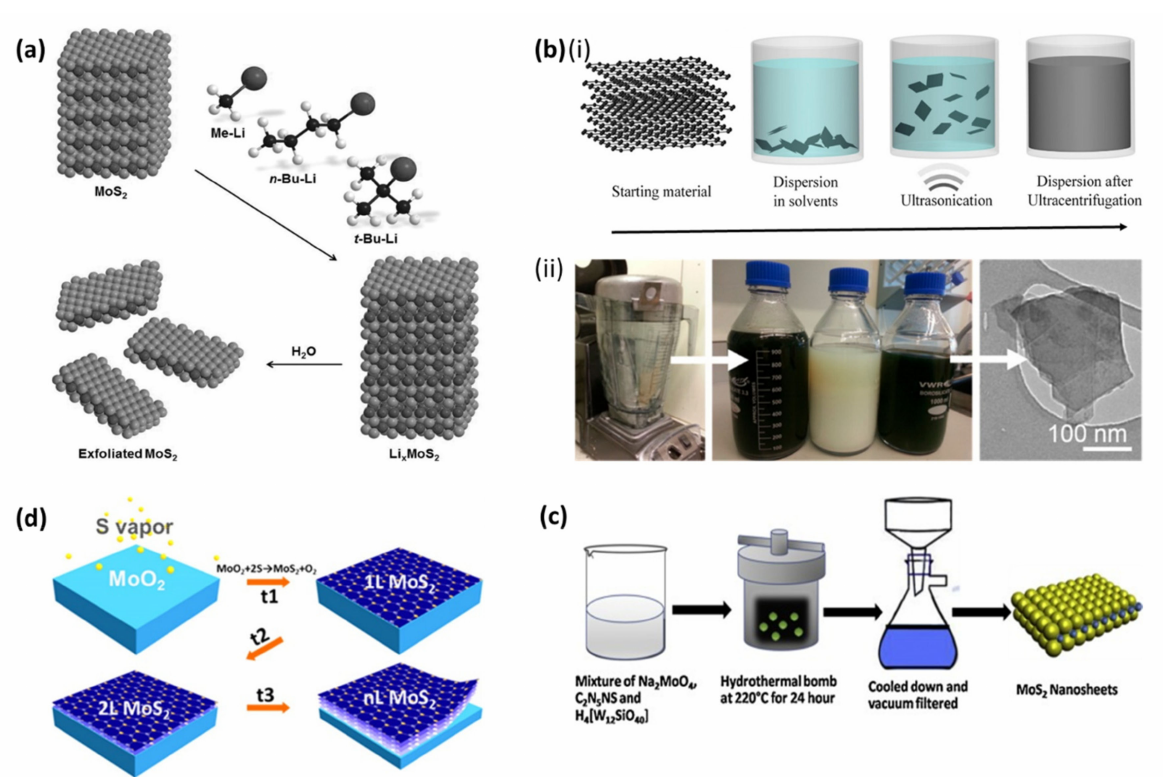
Figure 1. Schematic diagrams of ( a ) lithium intercalation exfoliation [44], ( b ) (i) exfoliation by sonication [48], (ii) exfoliation by high shear rate using a basic kitchen blender [50], ( c ) hydrothermal synthesis [54], ( d ) CVD method [56]. Figures reproduced with permission from Ref. [44], © 2014 WILEY-VCH Verlag GmbH & Co. KGaA, Weinheim, Germany, Refs. [48,50] copyright ©